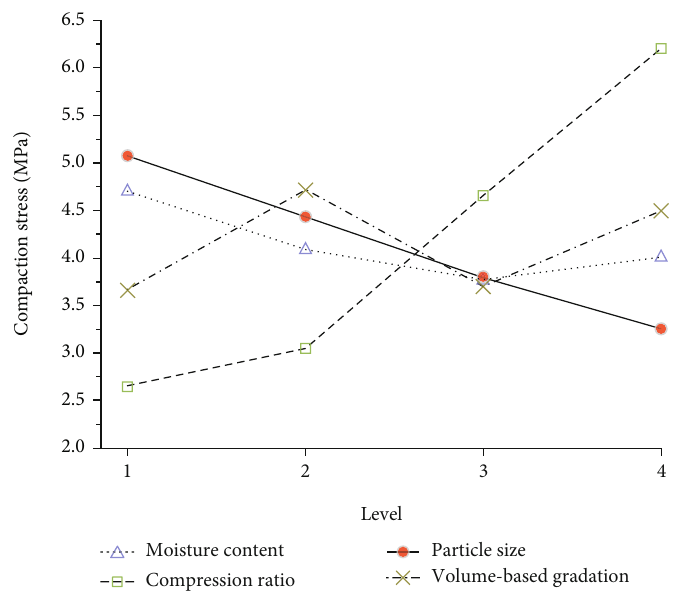
Figure 10: Sensitivity factor curves of the compaction Table 5: Ranges of the in fl uence factors of compressive strength. Test Range (MPa) Moisture content 0.099